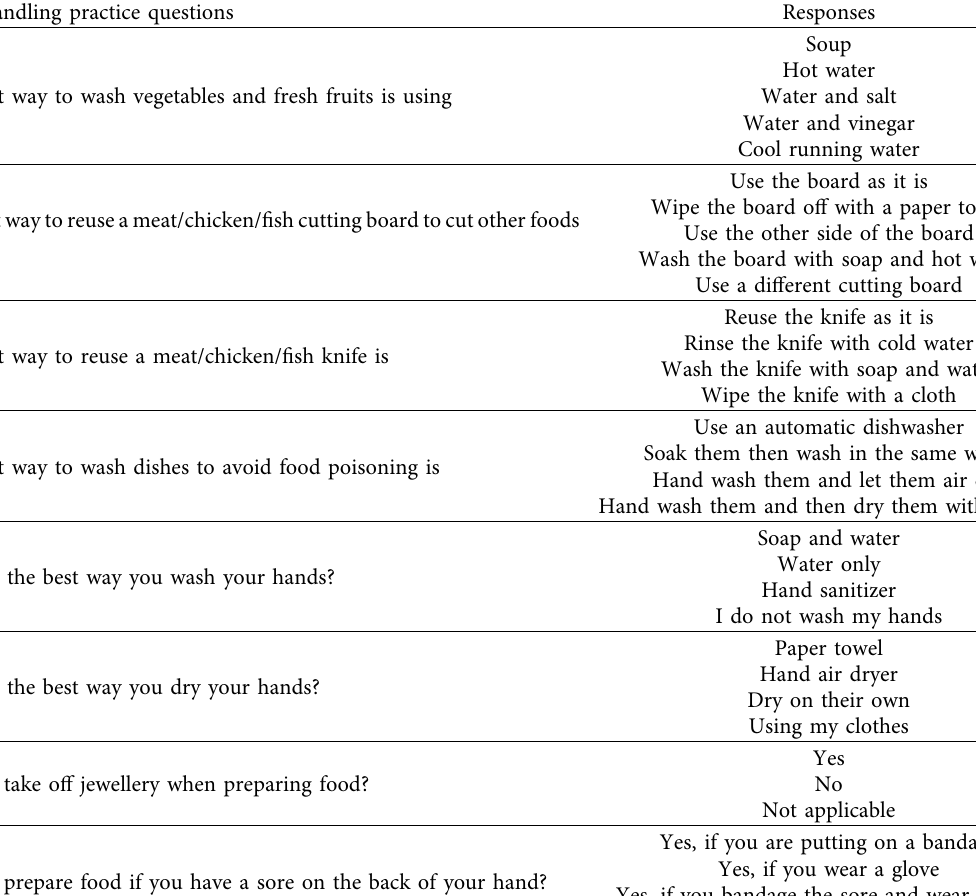
Table 3: Score distribution for food handling practices